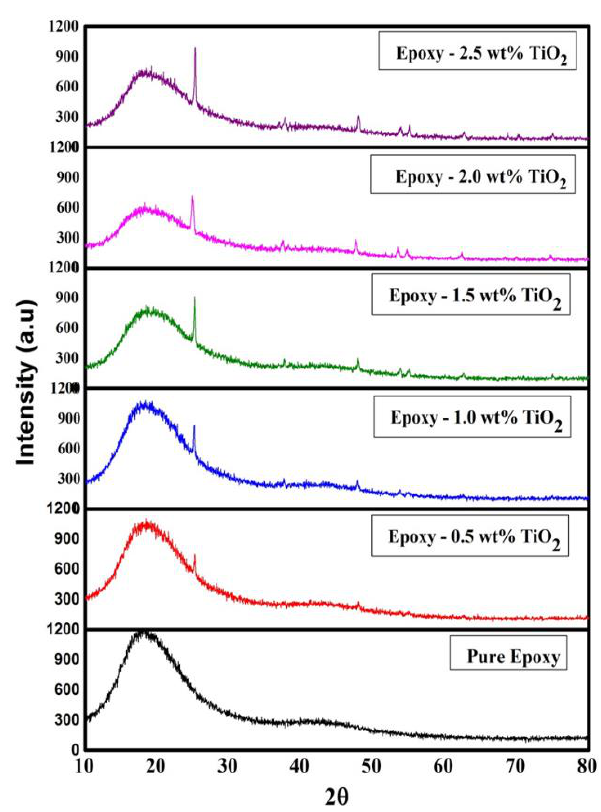
Fig. 2. X-ray diffraction profiles of (a) pure epoxy, (b) epoxy-0.5%wt. TiO 2, (c) epoxy-1.0%wt. TiO 2 (d) epoxy-1.5%wt. TiO 2 (e) epoxy-2.0%wt. TiO 2 and (f) epoxy-2.5%wt. TiO